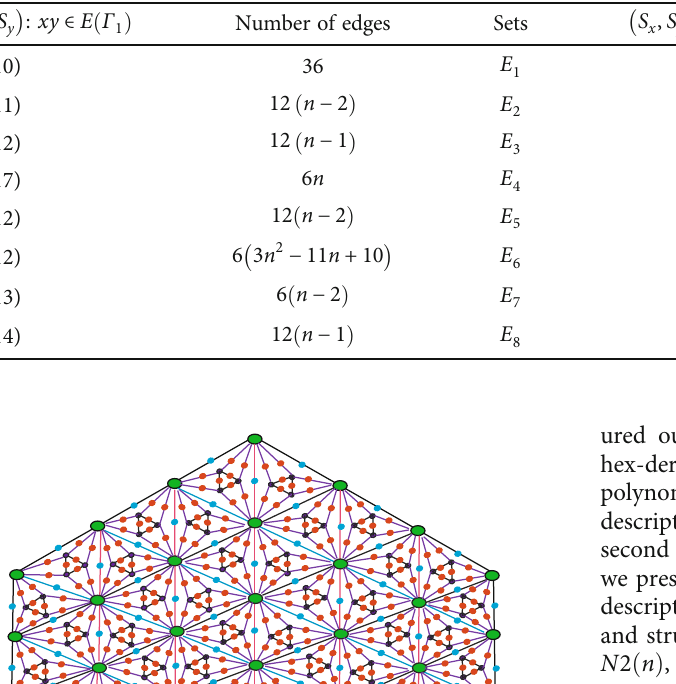
Table 3: Neighbors ’ degree sum based edge partitioning of Γ